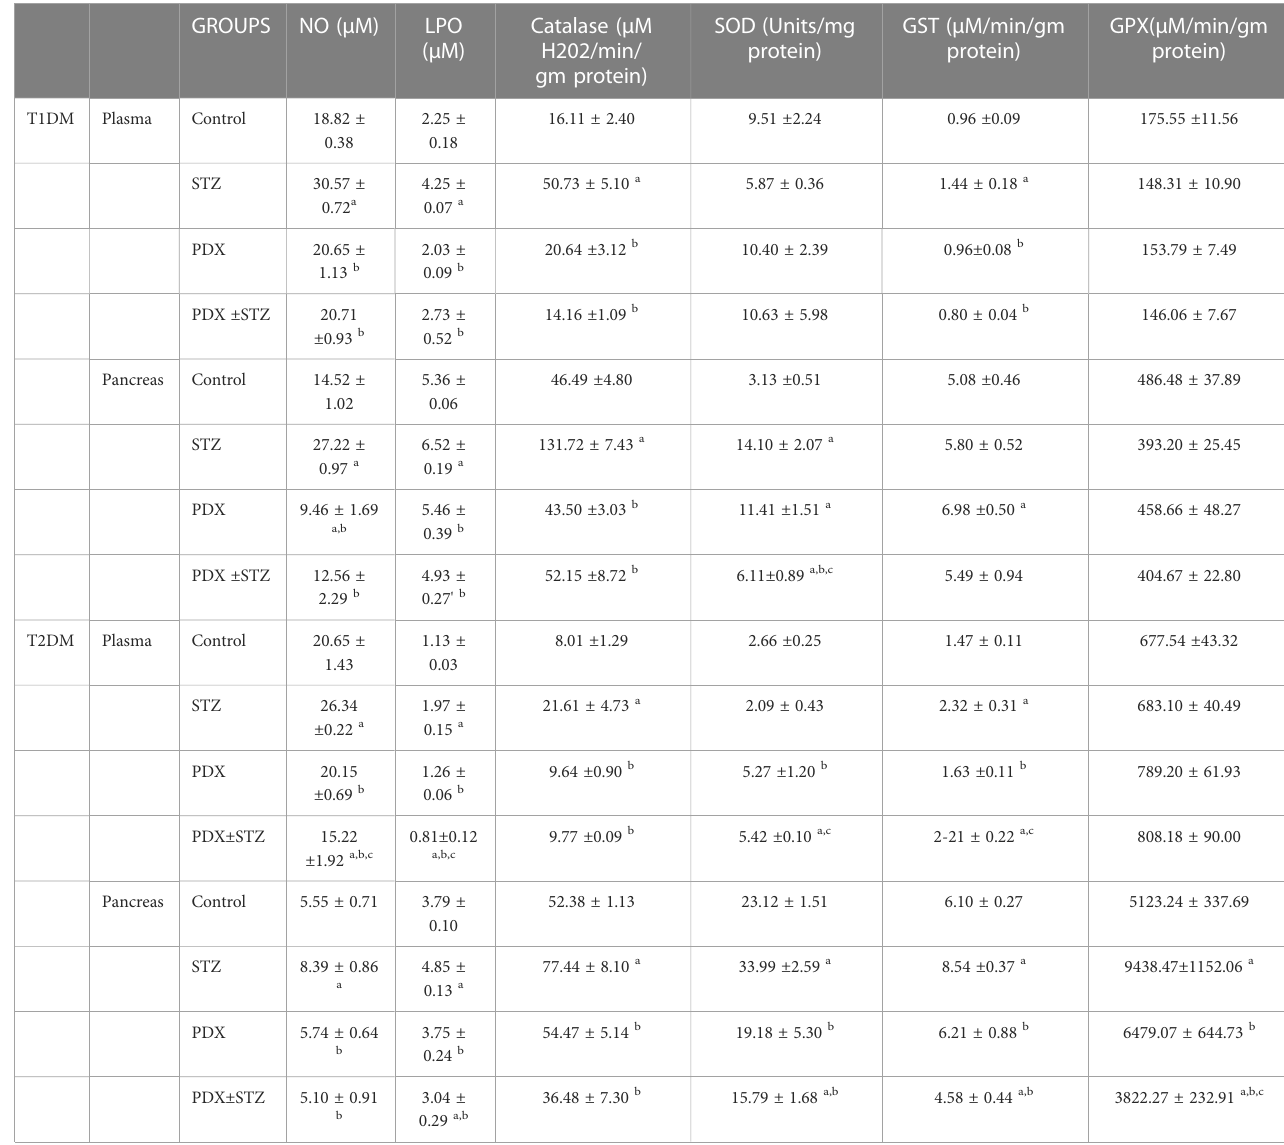
TABLE 4 Estimation of nitric oxide, lipid peroxidation and anti-oxidant status in Type 1 DM and Type 2 DM